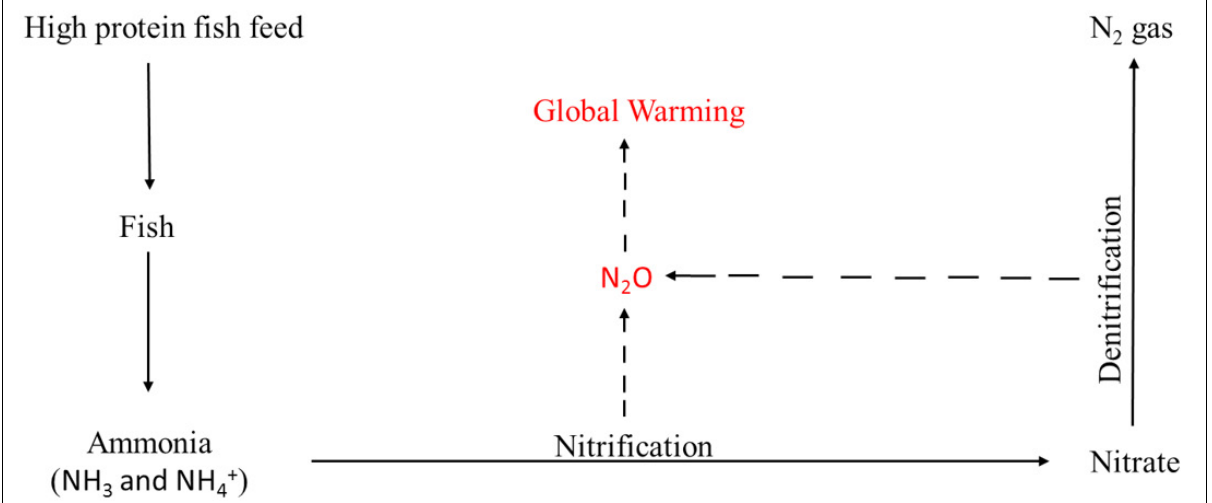
O) emissions from 2